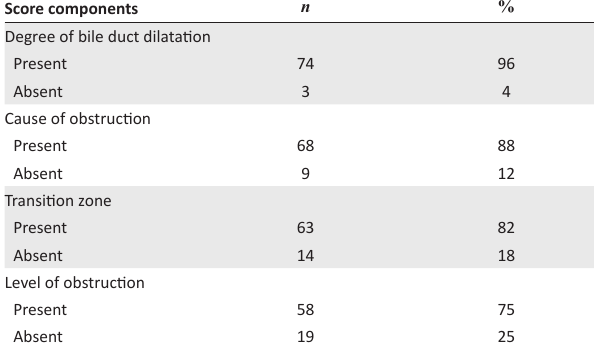
TABLE 2: Report adequacy score